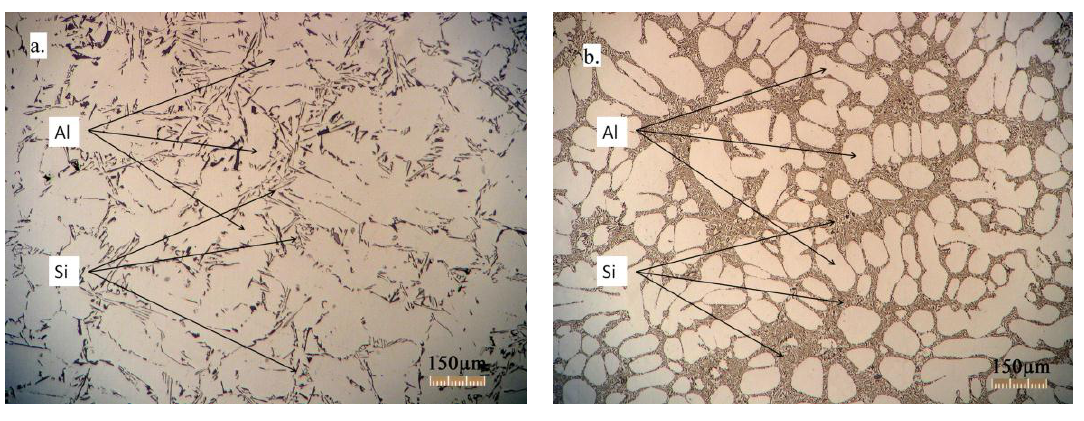
Figure 3. Optical micrographs of А356 alloy before ( а ) and after GDT ( b ). Large α-Al grains are refined into fine equiaxed grains surrounded by homogeneously-distributed eutectic Si